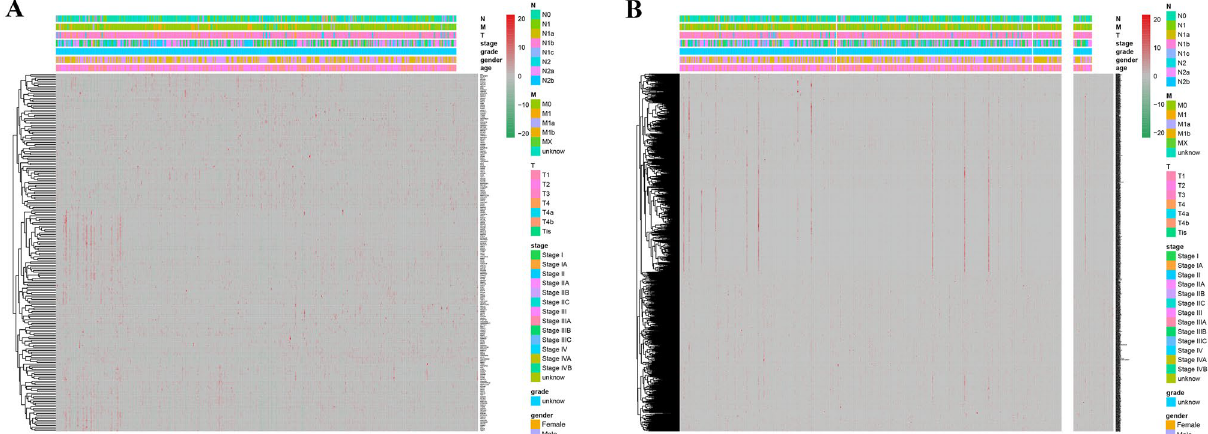
Figure 1. The heatmap of autophagy-related lncRNAs and genes in TCGA